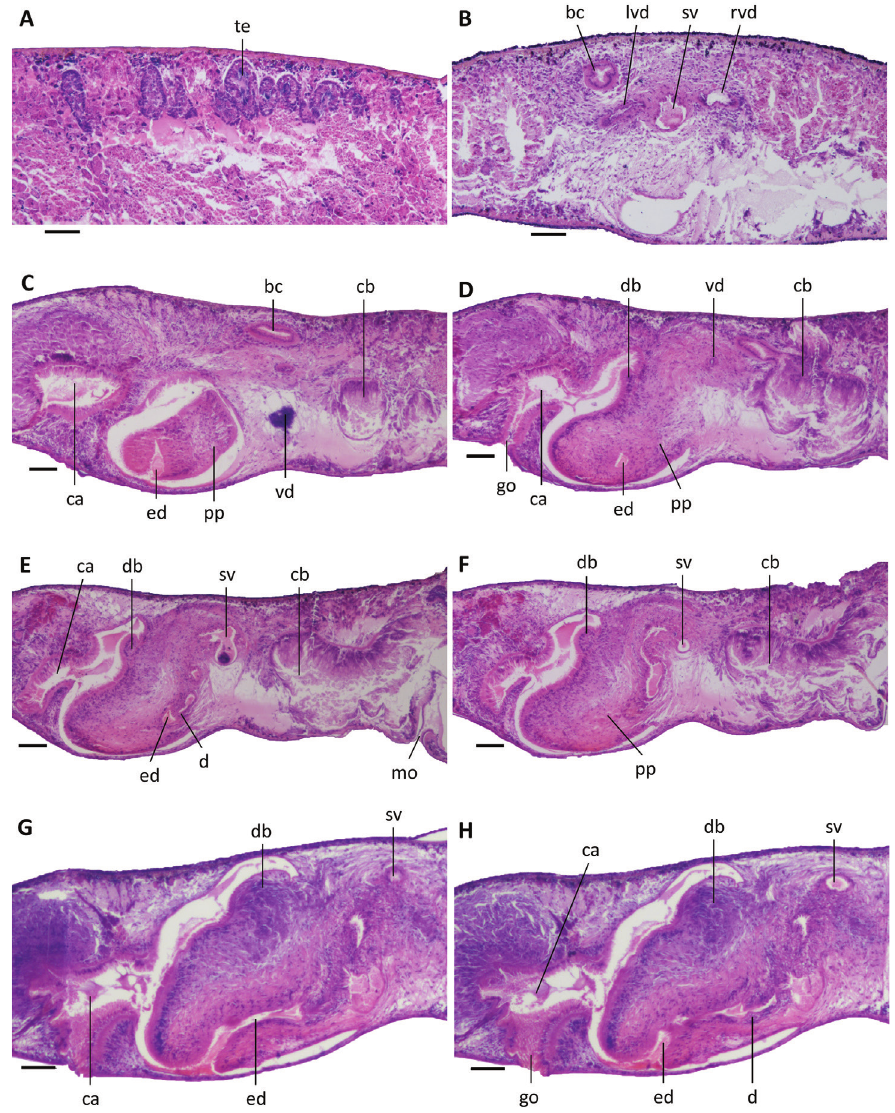
Figure 12. Dugesia verrucula A sagittal section of holotype ZJYA5, showing the testes B transverse section of paratype ZJYA7, showing vasa deferentia and seminal vesicle C sagittal section of holotype ZJYA5, showing subterminal opening of ejaculatory duct at tip of penis papilla D sagittal section of holo- type ZJYA5, showing dorsal bump and copulatory bursa E sagittal section of holotype ZJYA5, showing seminal vesicle, diaphragm in the ejaculatory duct, dorsal bump, and copulatory bursa F sagittal section of holotype ZJYA5, showing seminal vesicle, dorsal bump, and copulatory bursa G sagittal section of paratype ZJYA11, showing subterminal opening of ejaculatory duct and dorsal bump H sagittal section of paratype ZJYA11, showing gonopore, ejaculatory duct, and diaphragm. Abbreviations: bc: bursal ca- nal; ca: common atrium; cb: copulatory bursa; d: diaphragm; db: dorsal bump; ed: ejaculatory duct; go: gonopore; lvd: left vas deferens; mo: mouth; pp: penis papilla; rvd: right vas deferens; sv: seminal vesicle; te: testis; vd: vas deferens. Scale bars: 100